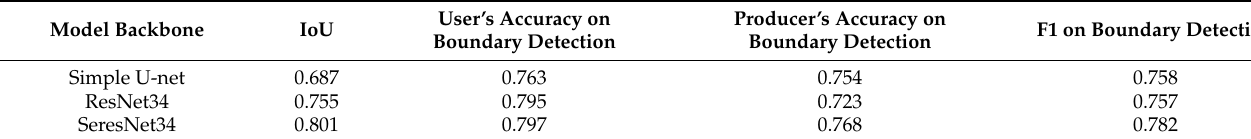
Table 2. Evaluation scores of the three image segmentation models.